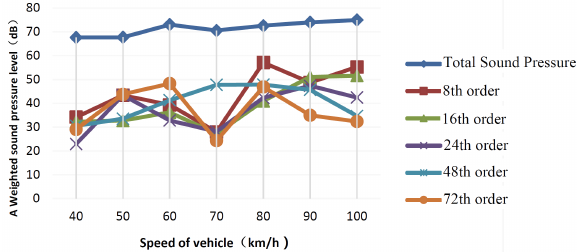
Fig. 5. Noise order analysis on the right side of Road (Constant driving speed